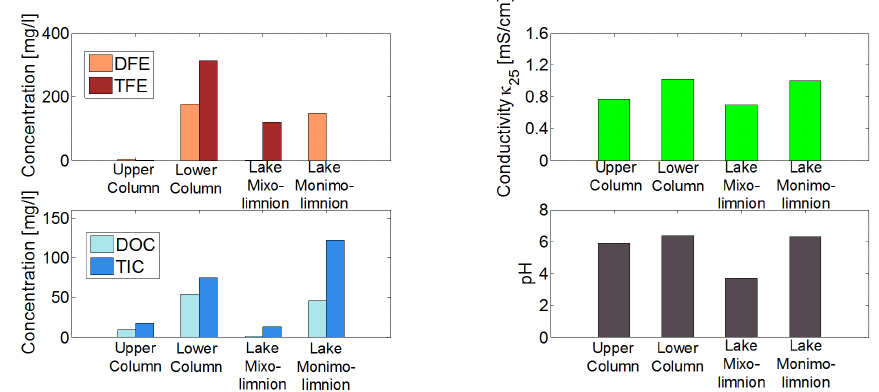
Figure 6. Iron species content (DFe and TFe), electrical conductivity, carbon species content (DOC and TIC) and pH value of samples from different water layers in Waldsee and the water column.